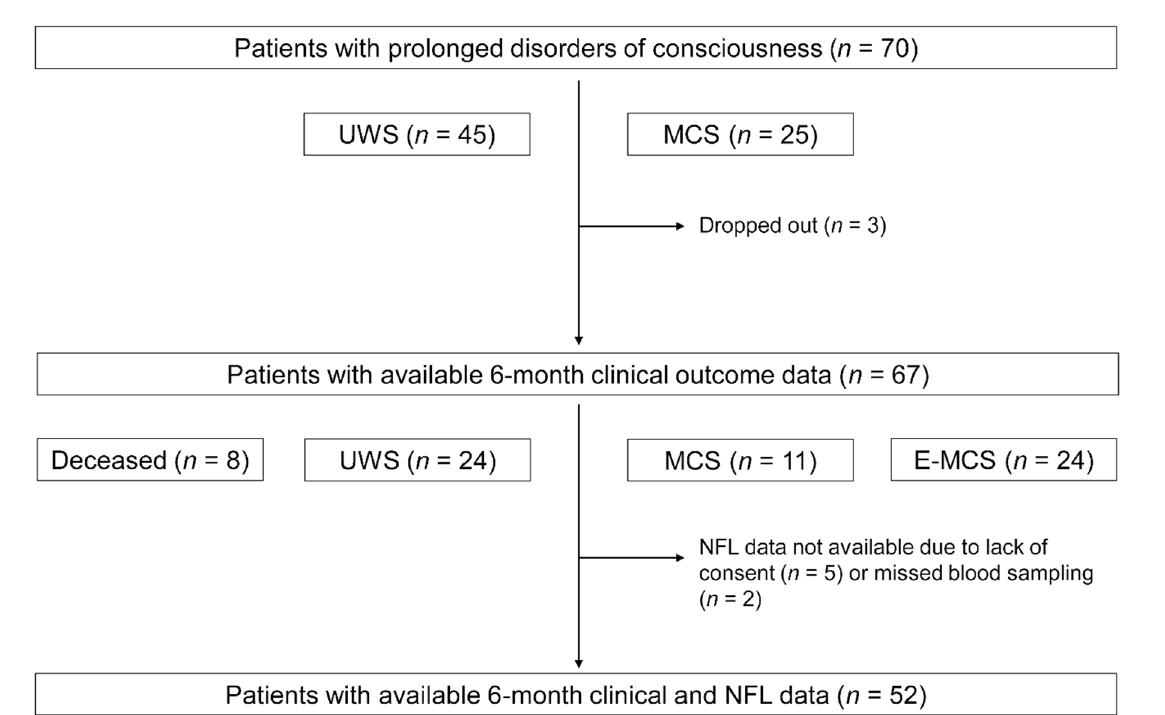
Figure 2. Distribution of NFL values in patients (at 1–3 and 6 months post-injury) and healthy con- trols. The horizontal lines indicate median values. One datapoint in the 1–3 months group is not reported because it fell outside of the axis limit. NFL, neurofilament light chain.